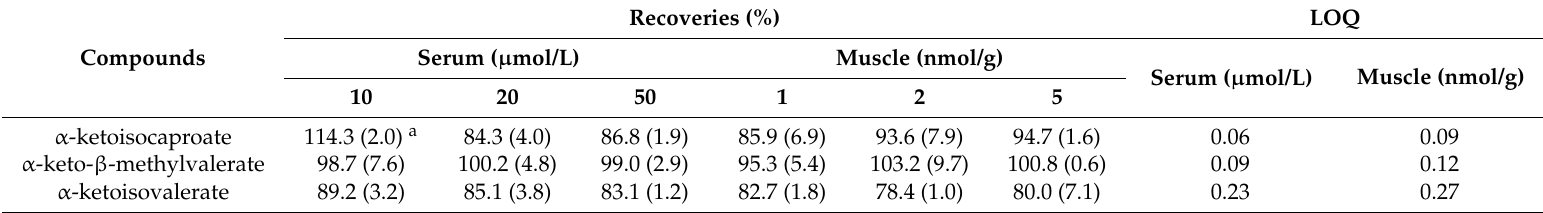
Table 2. Recoveries (%) and limit of quantification (LOQ) for detection of the branched-chain keto acids in spiked samples using UPLC-Q-TOF/MS ( n = 6).